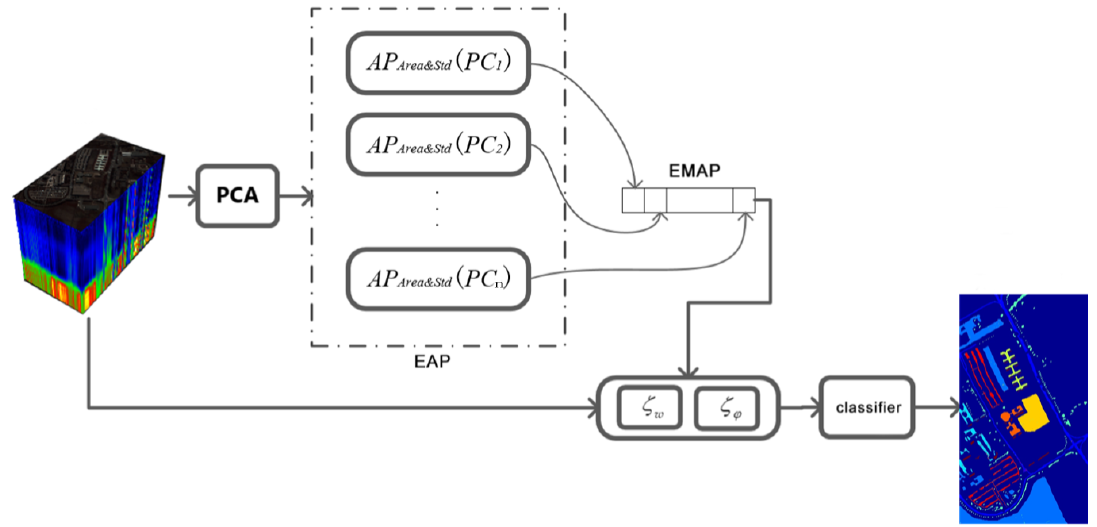
Figure 5. The principle of